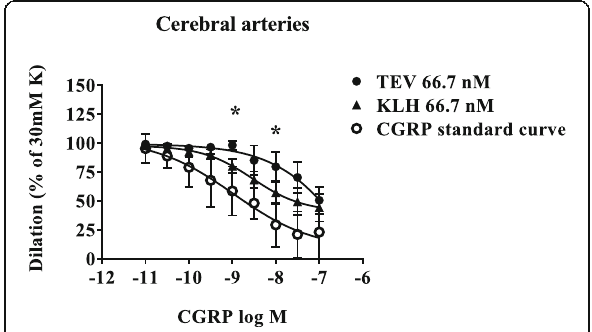
Fig. 2 Human intracranial arteries were pre-contracted with 30 mM potassium buffer. The curves show dilatation in response to increasing concentrations of α CGRP 10 − 11 to 10 − 7 M in the presence of 66.7 nM of the monoclonal antibody against CGRP (fremanezumab) or an isotype control (KLH). The data show mean±SEM, n =2 – 4 for each concentration. CGRP:calcitonin gene-related peptide; K:potassium; TEV:Teva